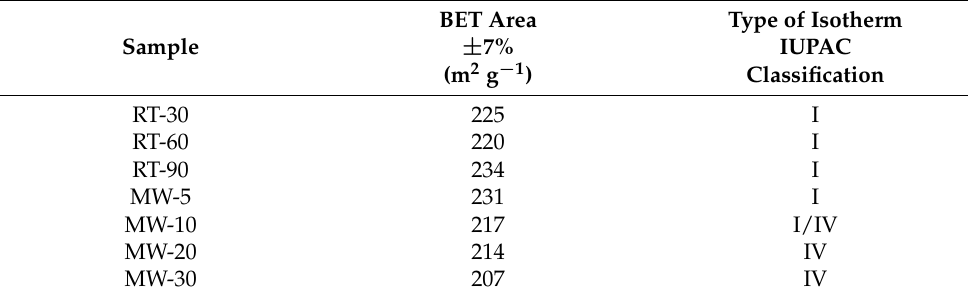
Table 4. Specific surface area of zinc ferrite